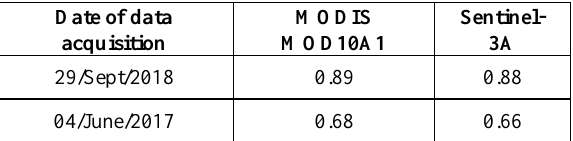
Table 3. Comparison of normalized SCA values obtained from MODIS MOD10A1 and Sentinel-3A